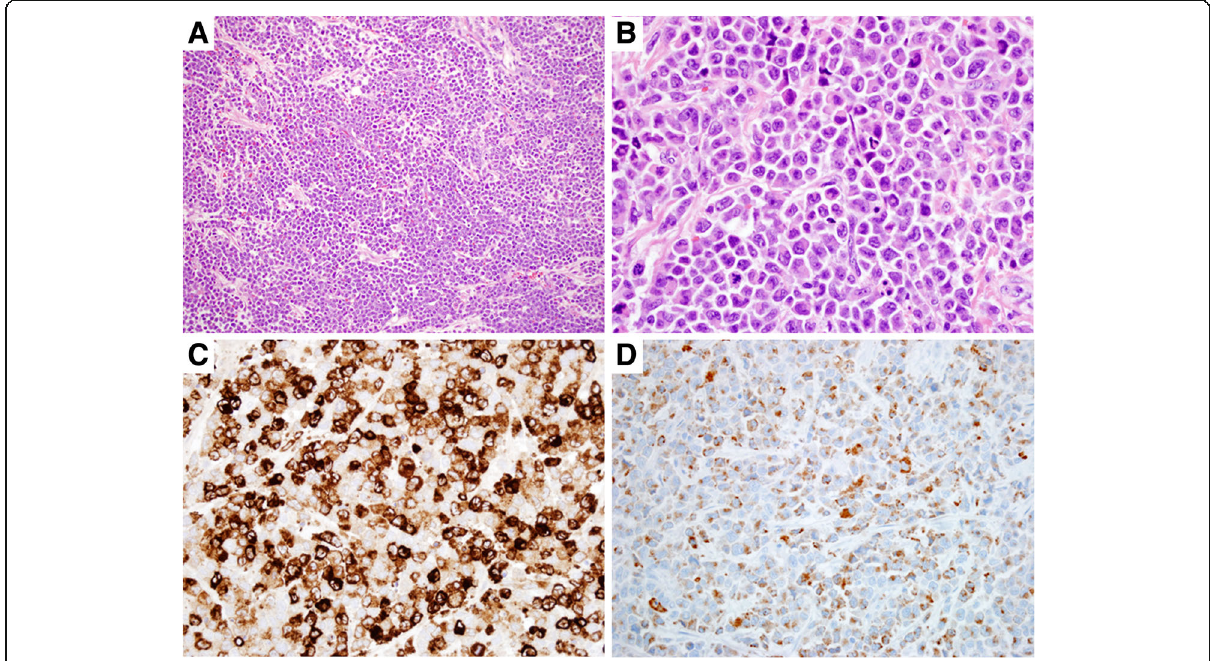
Fig. 1 Myeloid sarcoma with initial presentation as a vaginal wall mass. Histologic sections reveal extensive infiltrate by malignant cells that are large with irregular folded nuclear contours, open chromatin, variably prominent nucleoli and abundant cytoplasm ( a . HEx200, b . HE × 400). The neoplastic cells are variably positive for CD163 and weakly positive for CD68 ( c . CD163 × 400, d . CD68 ×